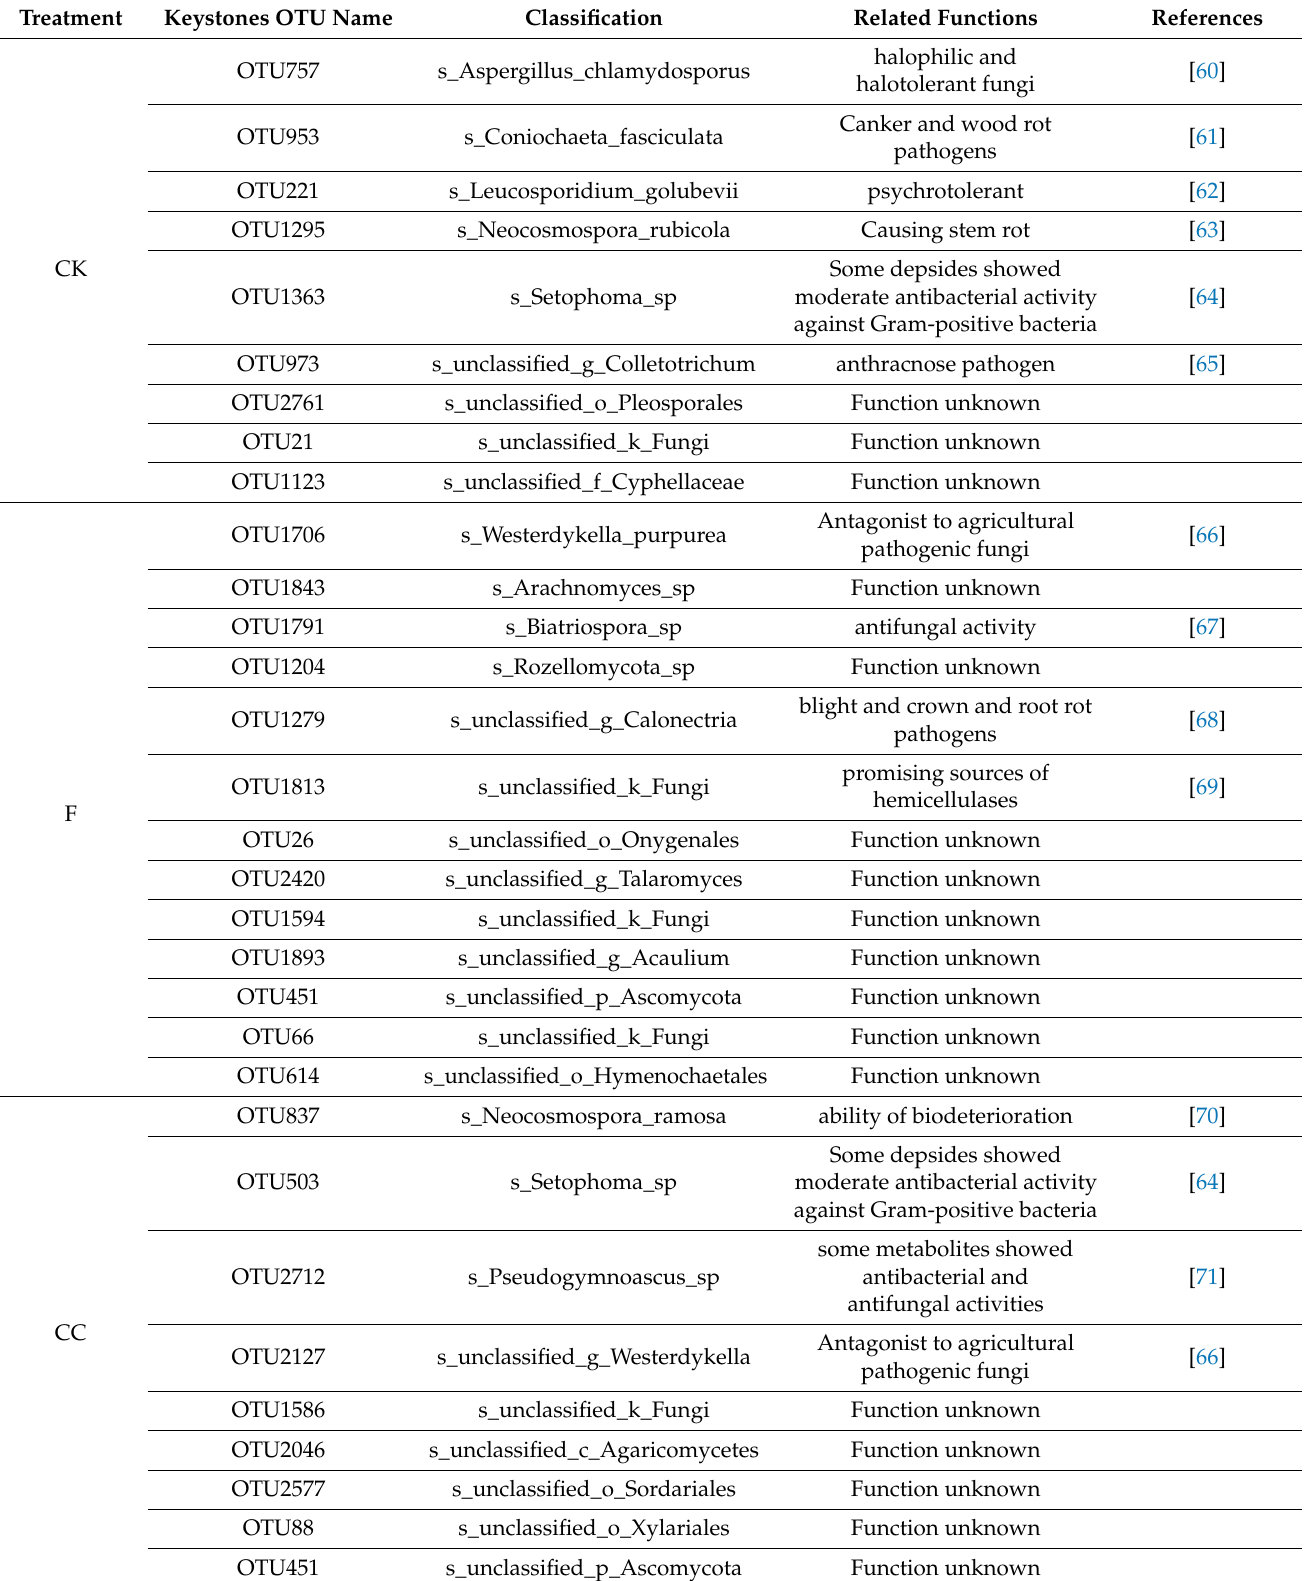
Table 4. The classification and related functions of keystone taxa in the fungal